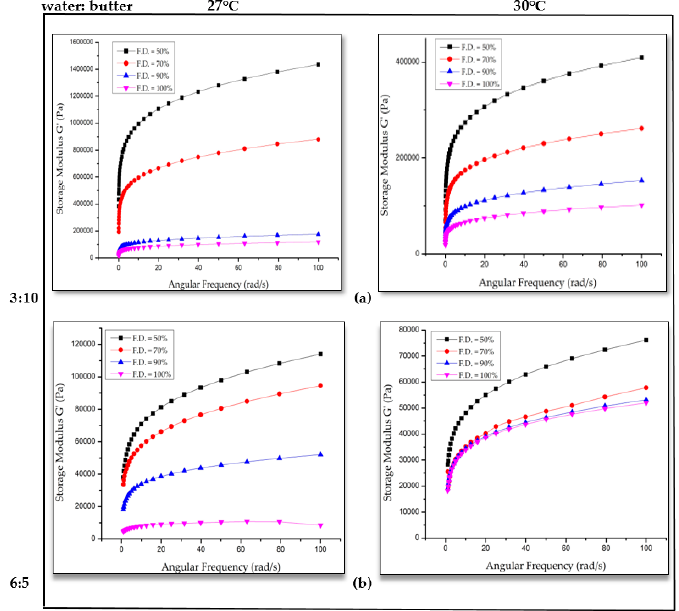
Figure 3. Storage modulus (G’) versus angular frequency of dough at different water ratios ( a ) 3:10 and ( b ) 6:5 at 27 °C and 30 °C.